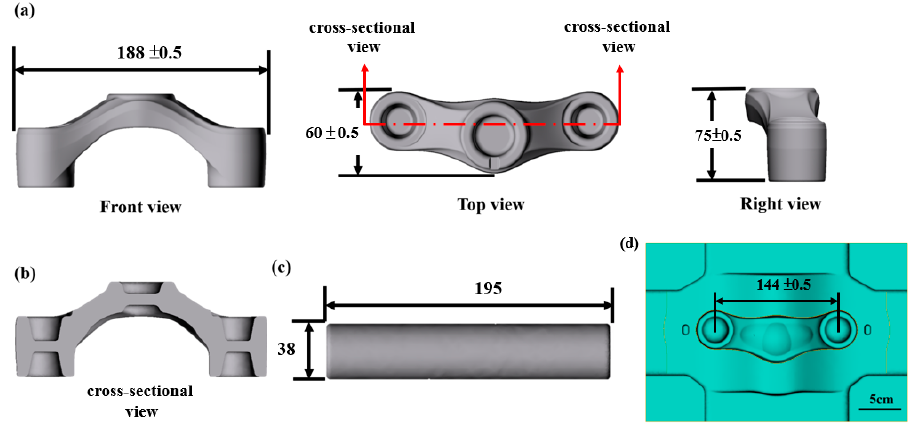
Figure 1. Original workpiece dimensions for crown forgings (in mm). ( a ) CAD model with views in front, top, and right; ( b ) a cross-sectional view of the crown forging workpiece; ( c ) relevant dimensions of the billet; ( d ) the dimension of bottom die.